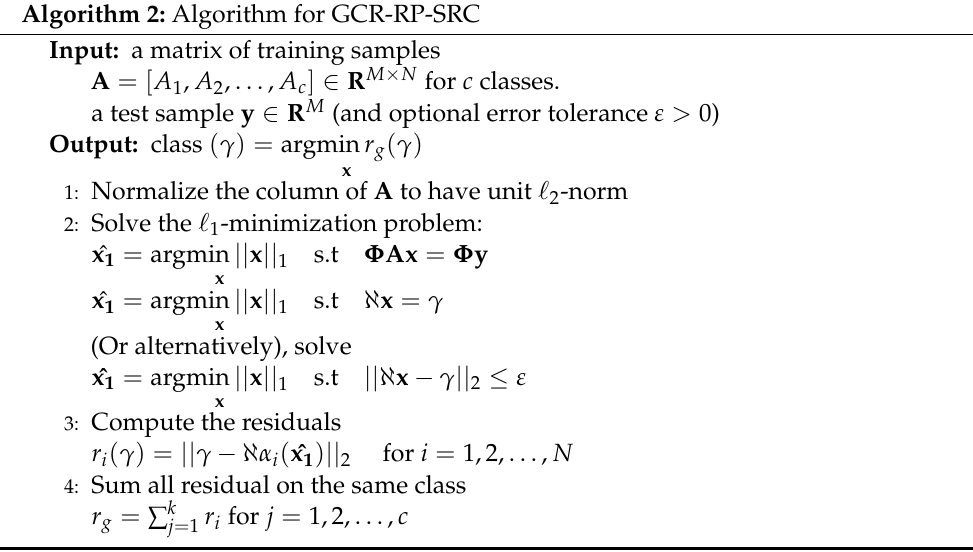
Algorithm 2: Algorithm for GCR-RP-SRC